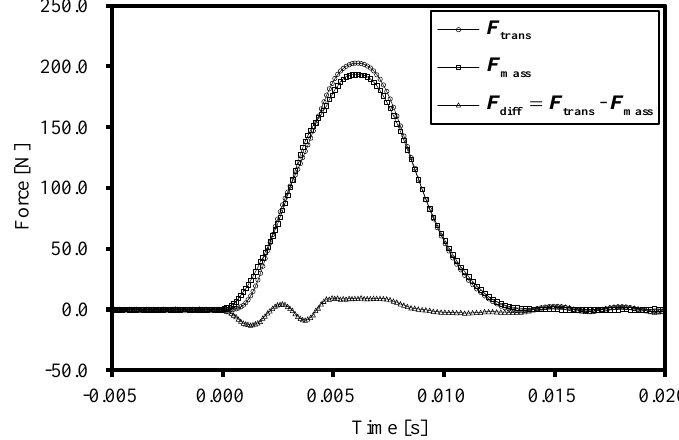
Figure 2. The force measured with the transducer F interferometer F and the difference between the forces. mass